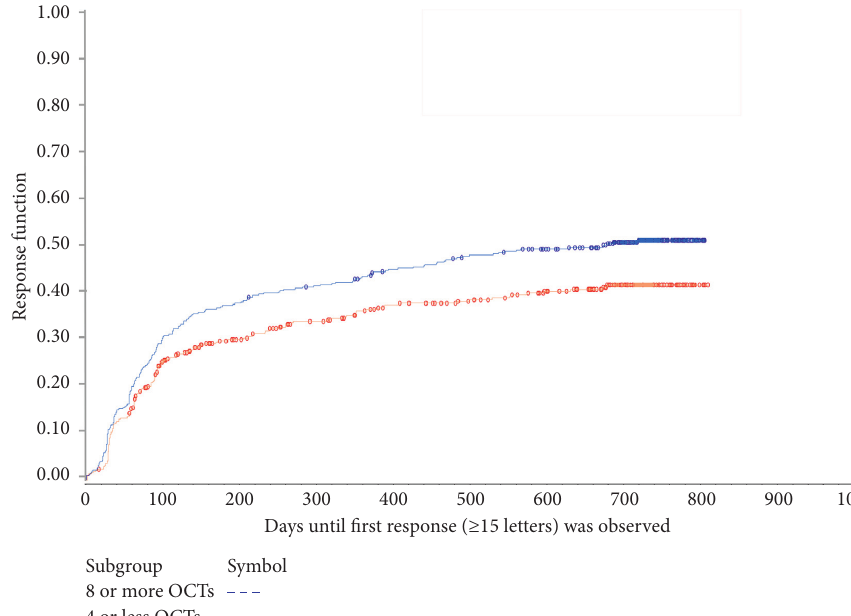
Figure 6: Days until the first response was observed (change from baseline of ≥ 15 letters) for patients receiving ≤ 4 OCT or ≥ 8 OCT examinations. OCT: optical coherence